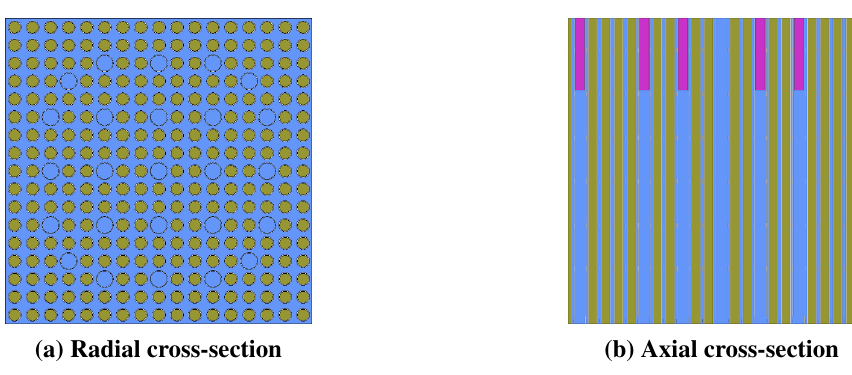
Figure 1: Radial (1a) and axial (1b )cross-sections of 2.4% wt. U-235 fuel